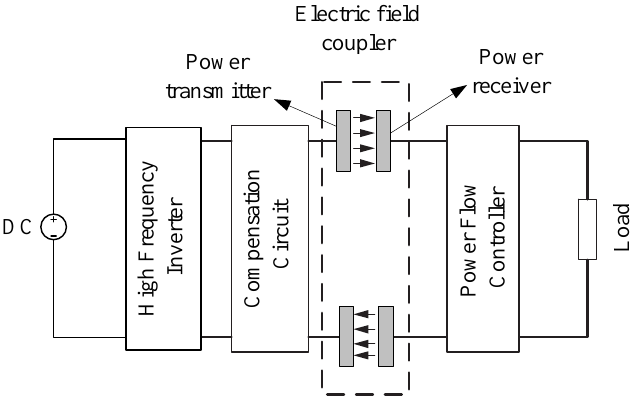
Figure 3. The structure of a typical CCPT system, redrawn from Huang et al. [11].